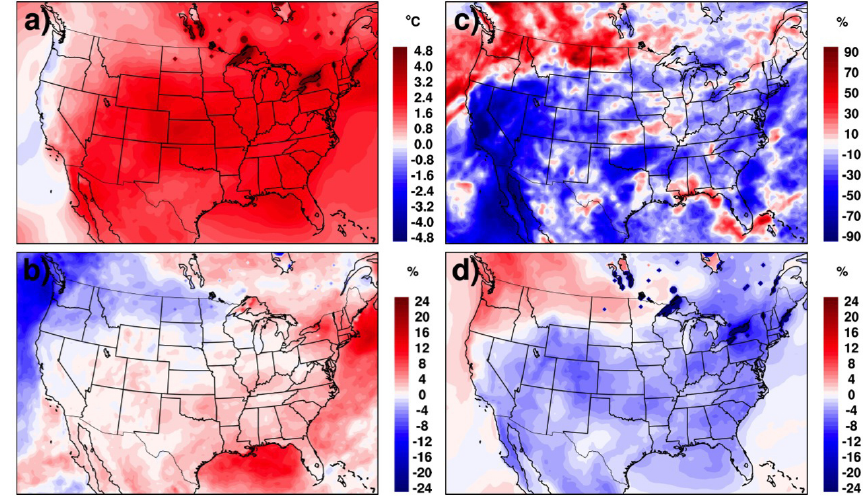
Figure 9. Projected changes in summertime meteorological fields (future decade–current decade): (a) changes in 2m temperature ( ◦ C); (b) percent change in solar radiation reaching the ground; (c) percent change in precipitation; (d) change in relative